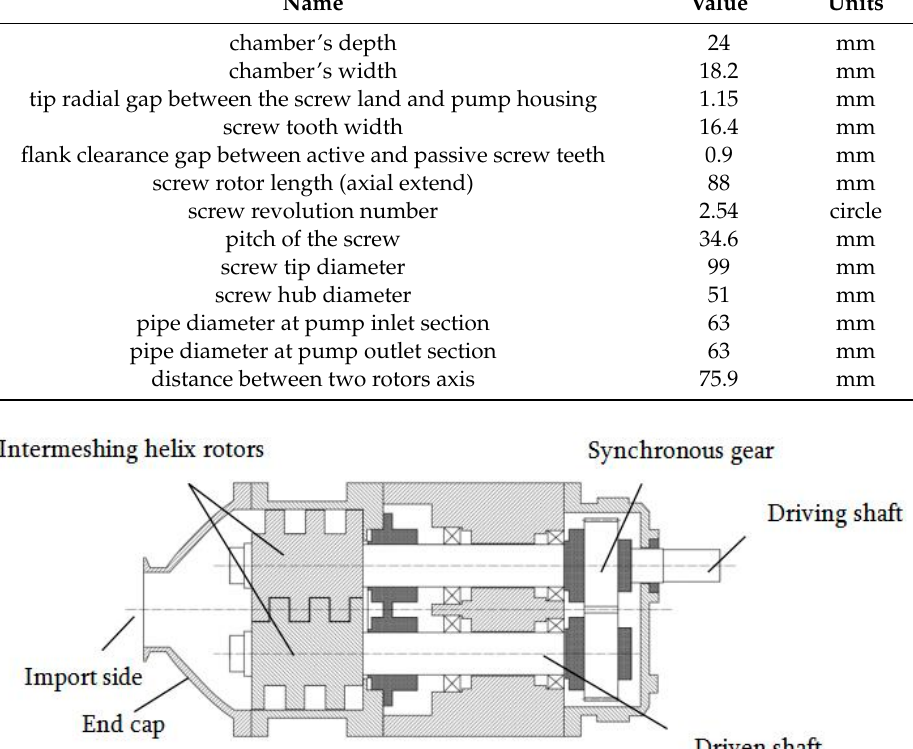
Figure 1. Schematic view of the double screw pump.